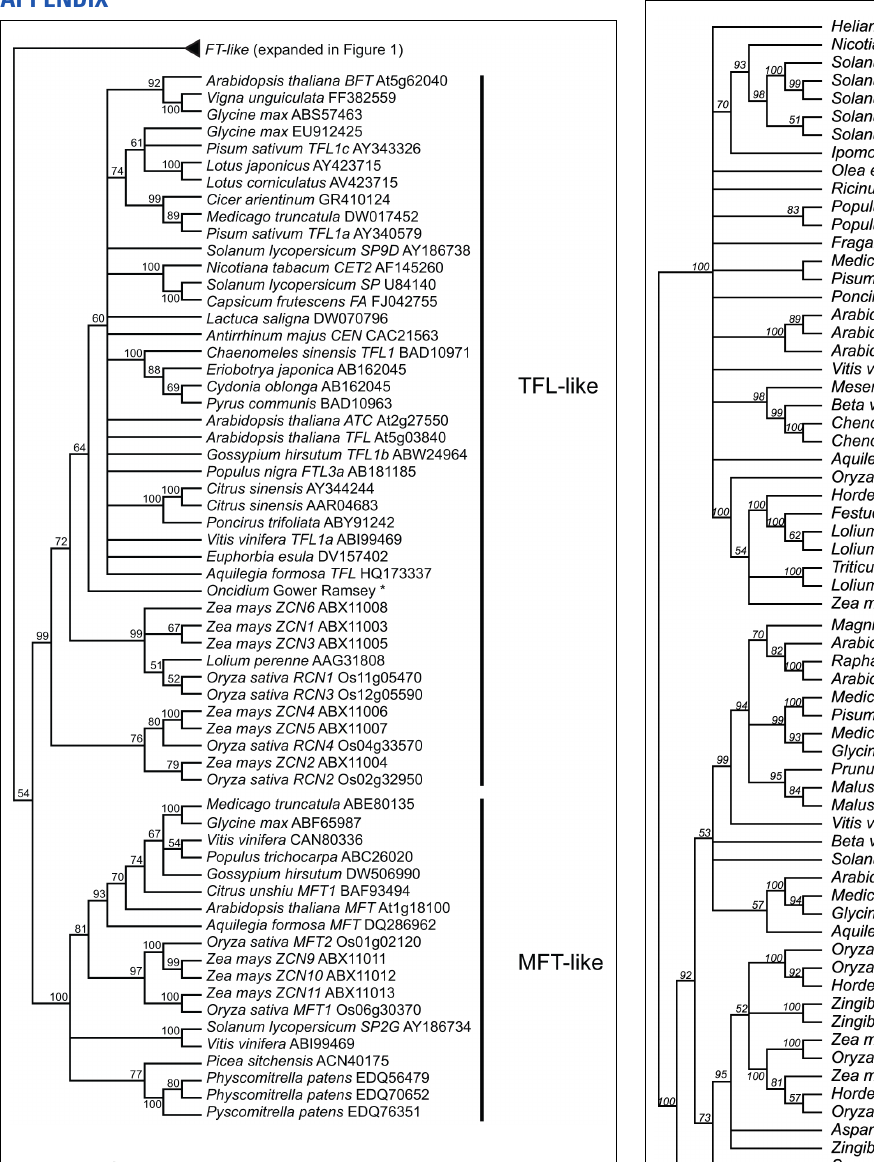
FIGUREA1 | Expansion of the PEBP gene tree to show TFL -like and MFT -like clades. Expansion of the tree presented in Figure 1 . ∗ Sequence for Oncidium Gower Ramsey was provided by C. H.Yang, National Chung Hsing University,Taichung,Taiwan, and does not have a GenBank accession number.